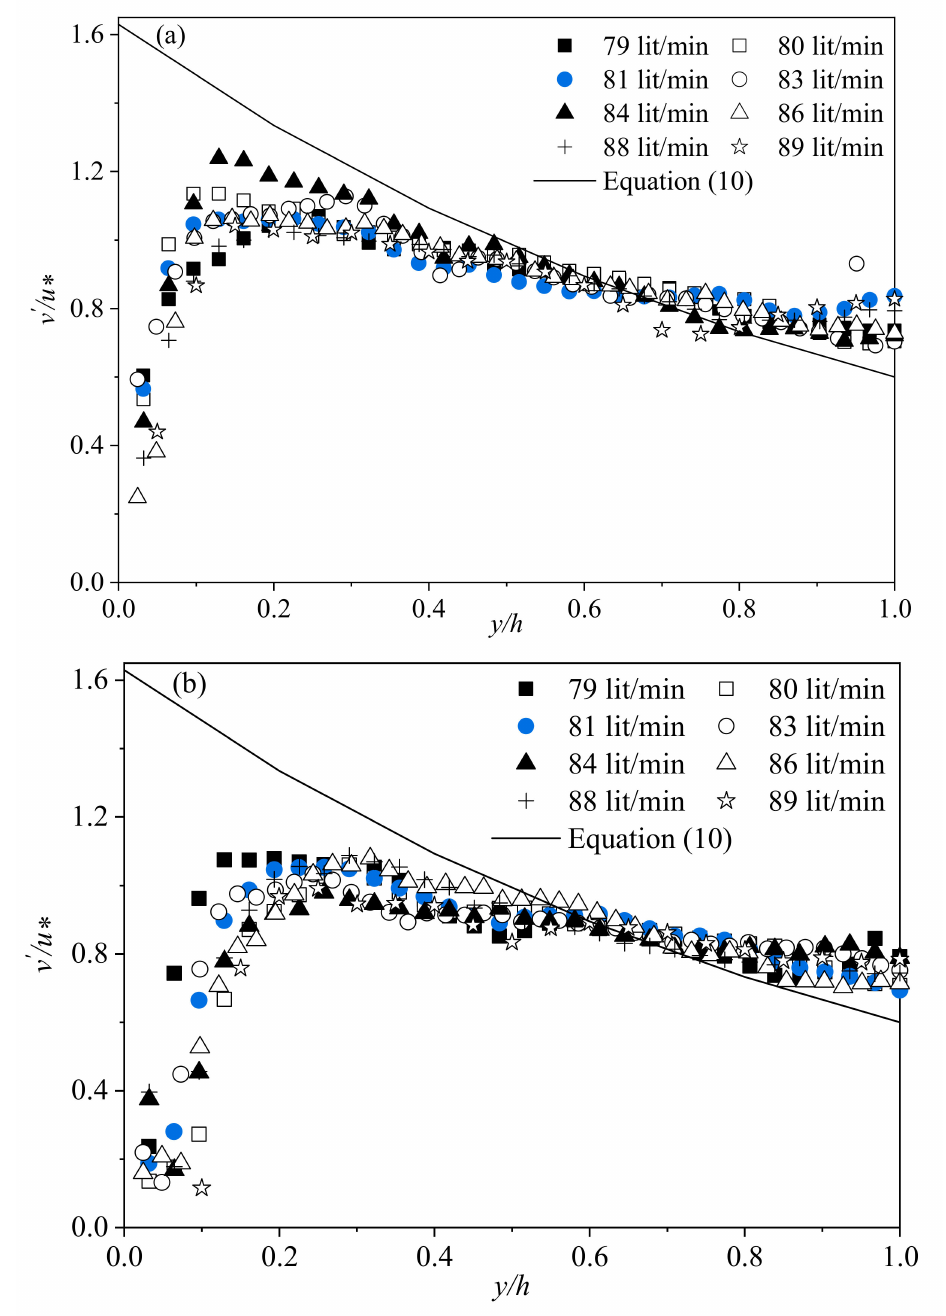
Figure 6. Vertical distributions of turbulence intensities in y -direction: ( a ) sand zone; and ( b ) smooth